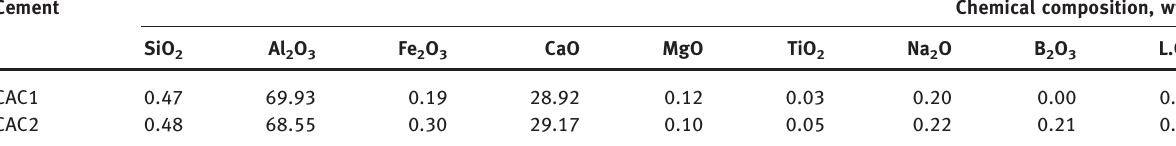
Table 1: Chemical composition of cements with and without B 2 O 3 . Cement